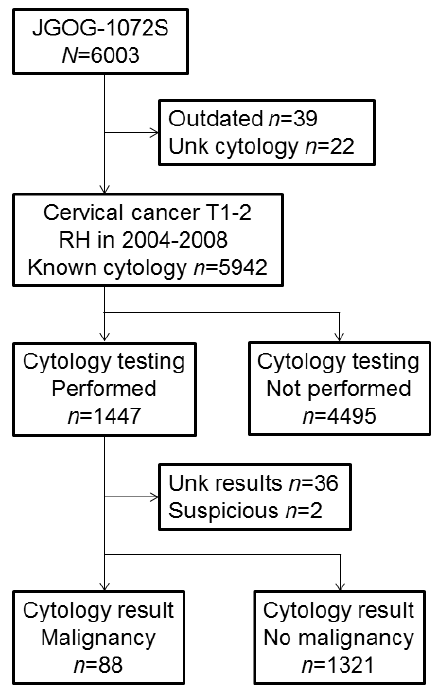
Figure 1. CONSORT diagram for study selection. Abbreviations: RH, radical hysterectomy; and unk, unknown.